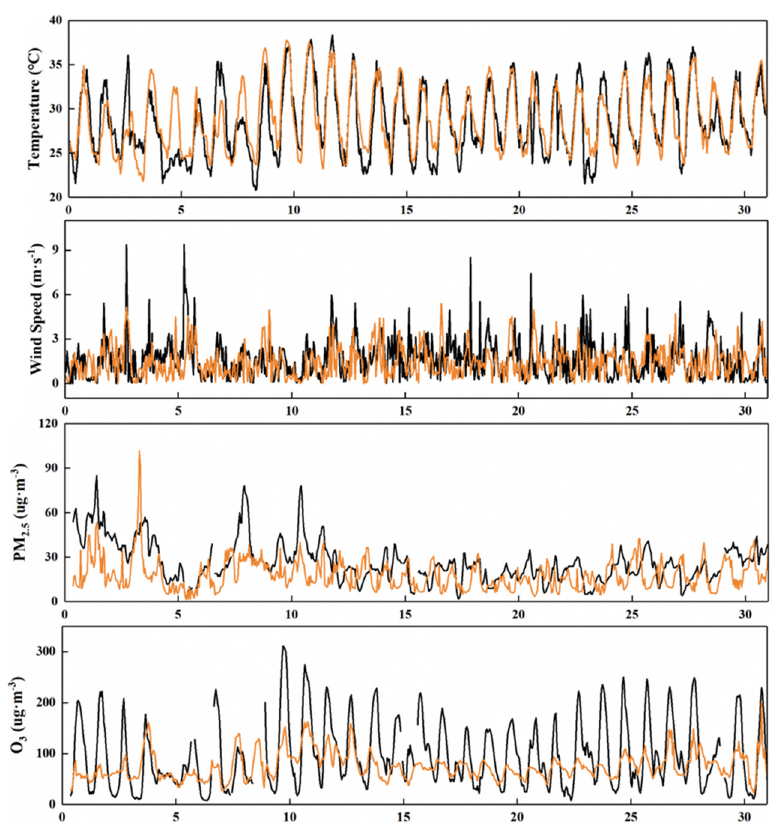
Figure 2. Time series of temperature at 2 m (T2), wind speed at 10 m (U10), PM 2.5 and O 3 concentra- tion in Chengdu in January 2017. Black is the observed value and orange is the simulated value.